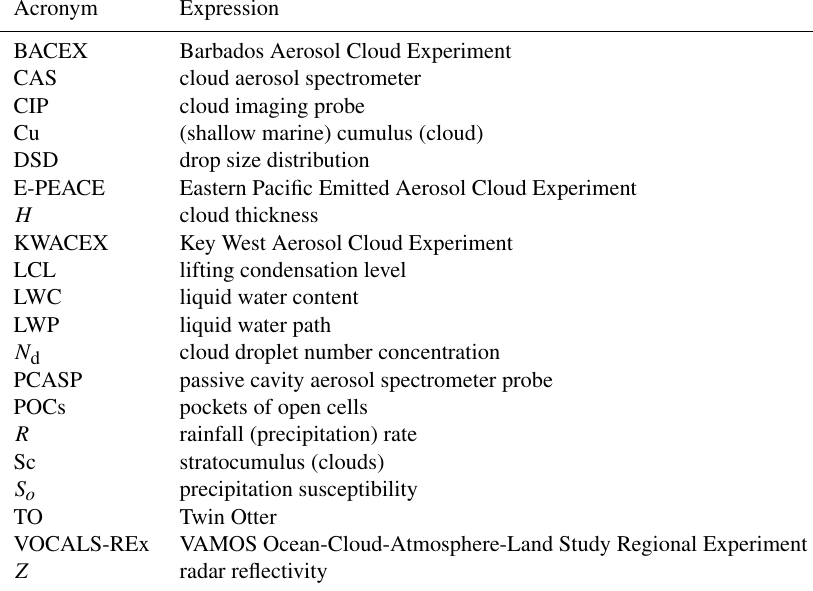
Table A1. Table of acronyms and